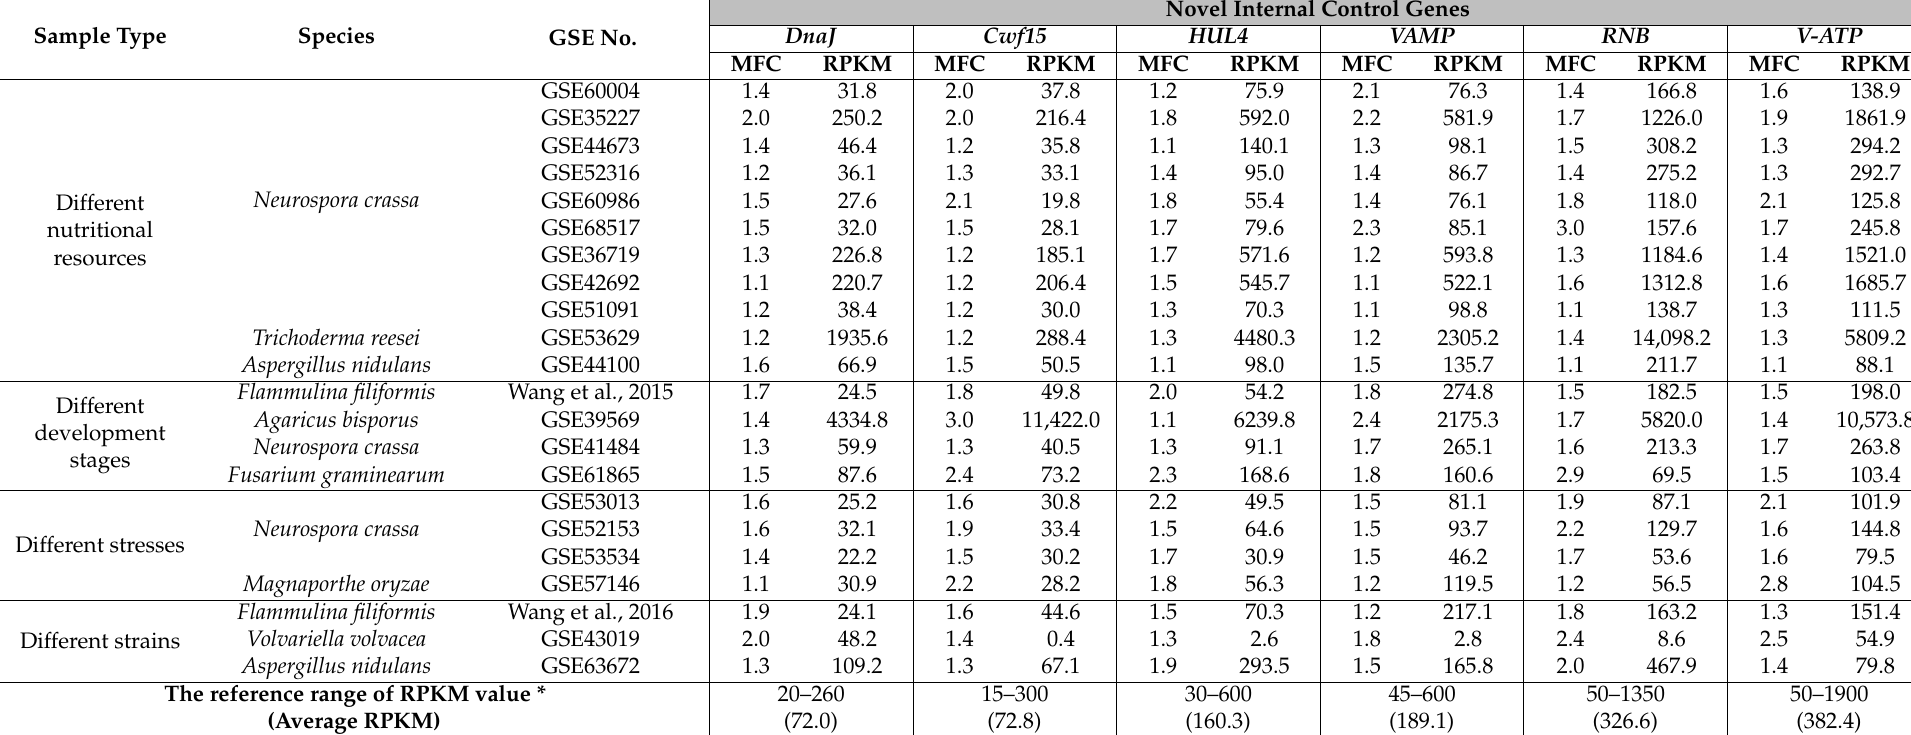
Table 2. The maximum fold change (MFC) and the average expression levels (RPKM) of the novel internal control